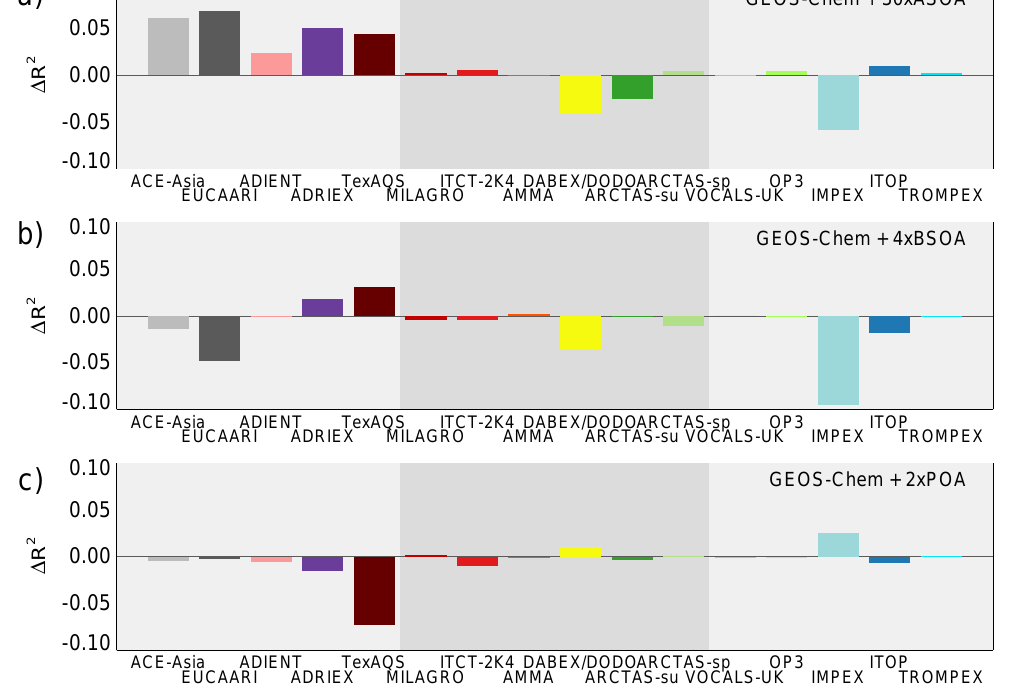
Fig. 12. The change in R 2 between simulated (GEOS-Chem) and observed OA for each campaign for various sensitivity simulations (labeled in inset). Each addition represents an additional source of 100Tgyr − 1 of OA. Compare to baseline in Fig. 7a.